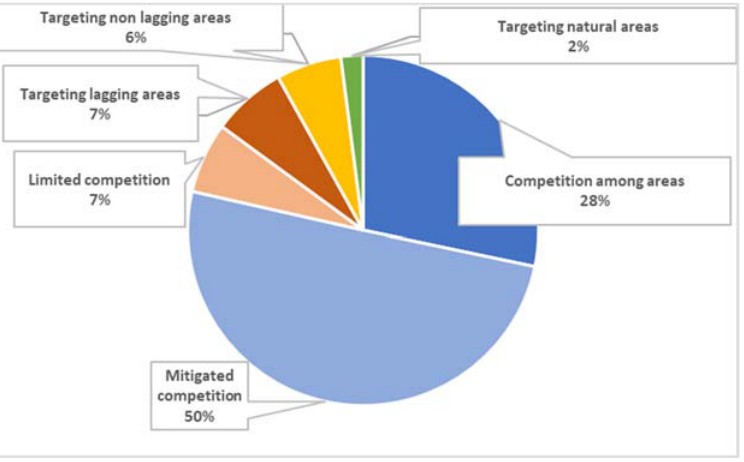
Figure 10. Distribution of committed expenditures by different modes of project selection (million EUR and %). Source: authors’ elaborations from the date base of funded investment projects.